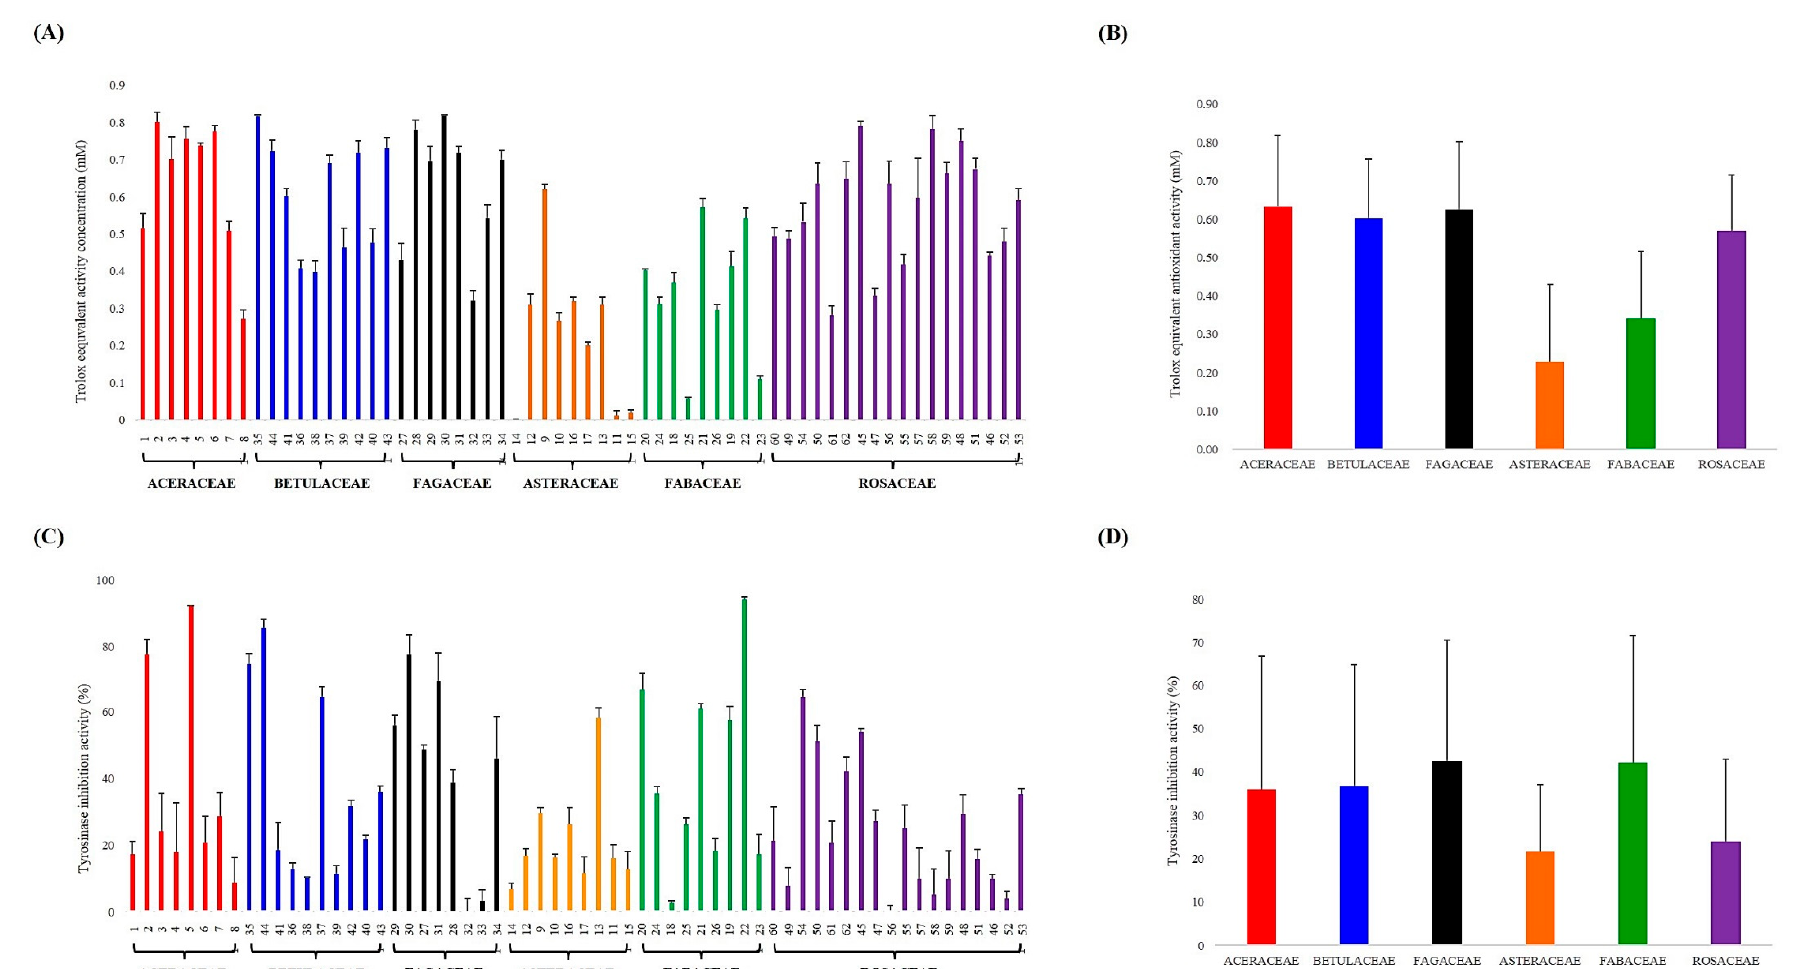
Figure 3. Antioxidant activity using DPPH radical scavenging assay ( A ) and tyrosinase inhibition activity ( C ) of 62 indigenous plant species, and average values of antioxidant ( B ) and tyrosinase inhibition activity ( D ) in each family.